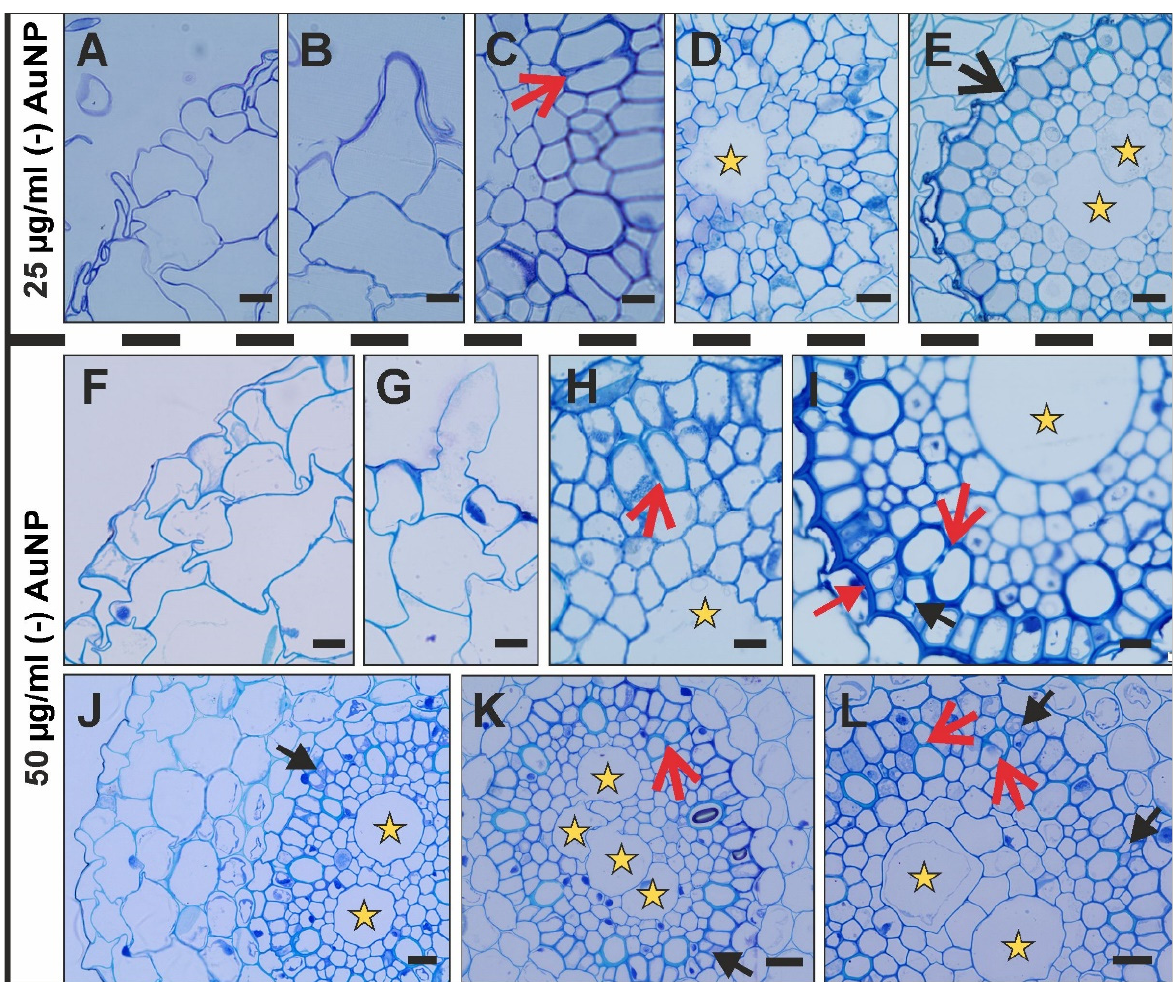
Figure 3. Cross-sections through the DZ (differentiation zone) of the roots growing in 25 µ g/mL (-) AuNP ( D – H ) or 50 µ g/mL (-) AuNP ( I – L ). Red open arrows—multiplicated metaxylem vessels; black open arrow— collapse of the endodermis; black arrow—atypical divisions of the pericycle cells; red arrow—ticked inner periclinal wall of the endodermis; yellow asterisks—central metaxylem. TBO staining. Scale bars: ( A – I ) = 10 μ m; ( E – G ) = 20 μ m.